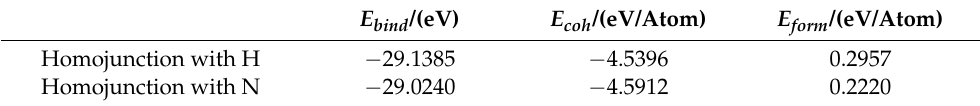
Table 2. Binding energy, cohesion energy, and enthalpy of formation for the two-atom model. E bind /(eV) E coh /(eV/Atom) E form /(eV/Atom) Homojunction with H − 29.1385 0.2957 Homojunction with N